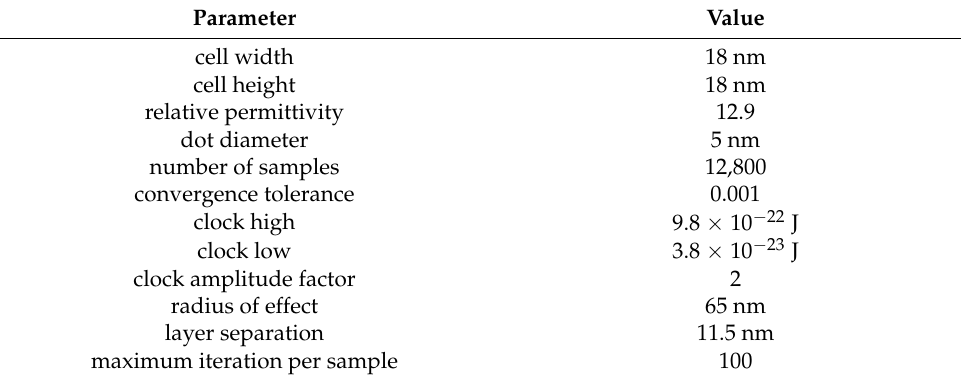
Table 1. Simulation parameters of the coherence vector tool.